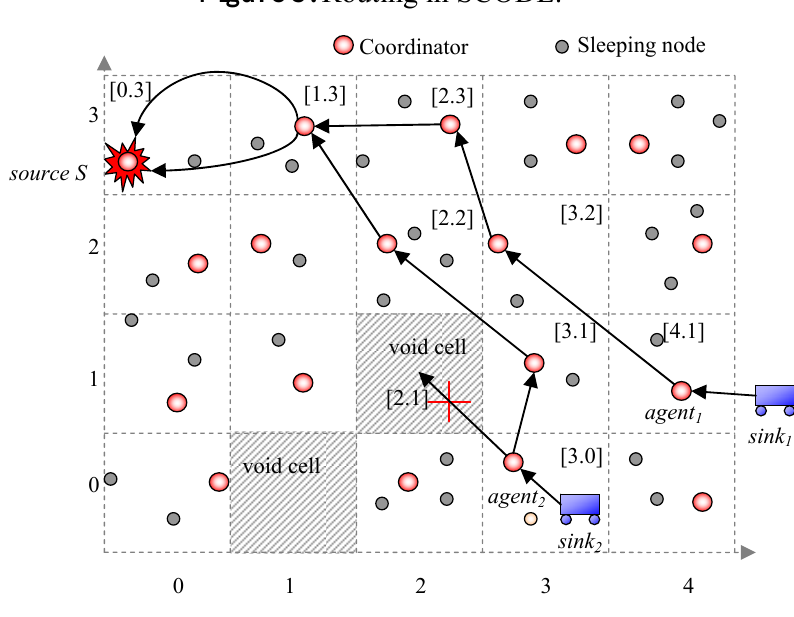
Figure 3. Routing in